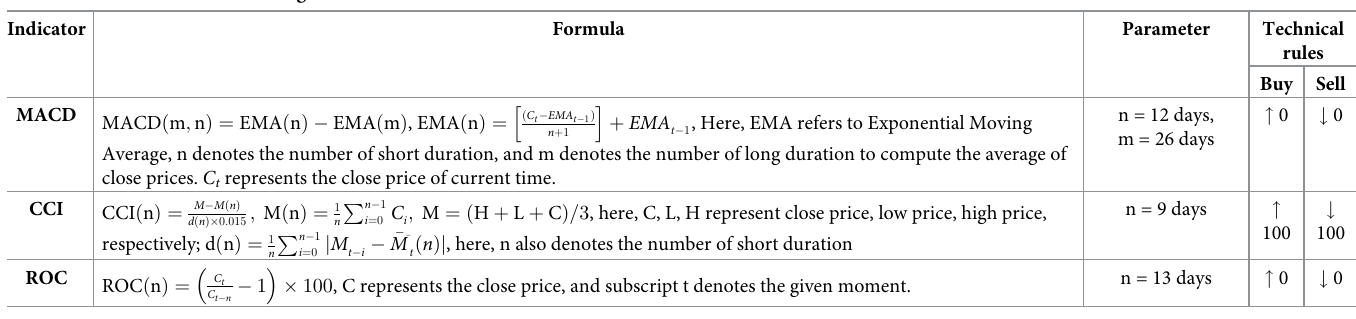
Table 2. Details of technical trading